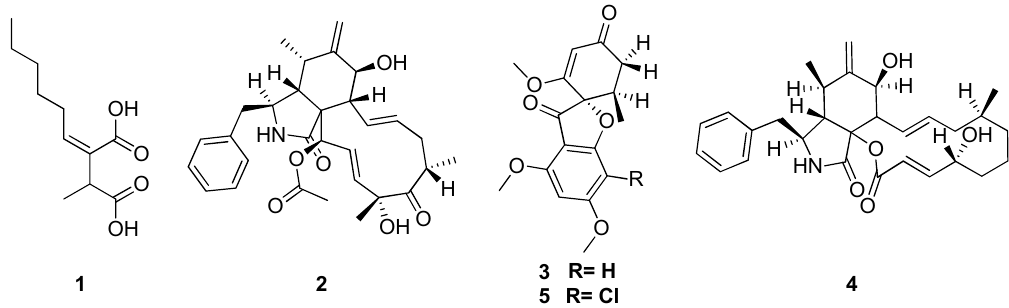
Figure 3. Five compounds extracted from Xylaria sp.